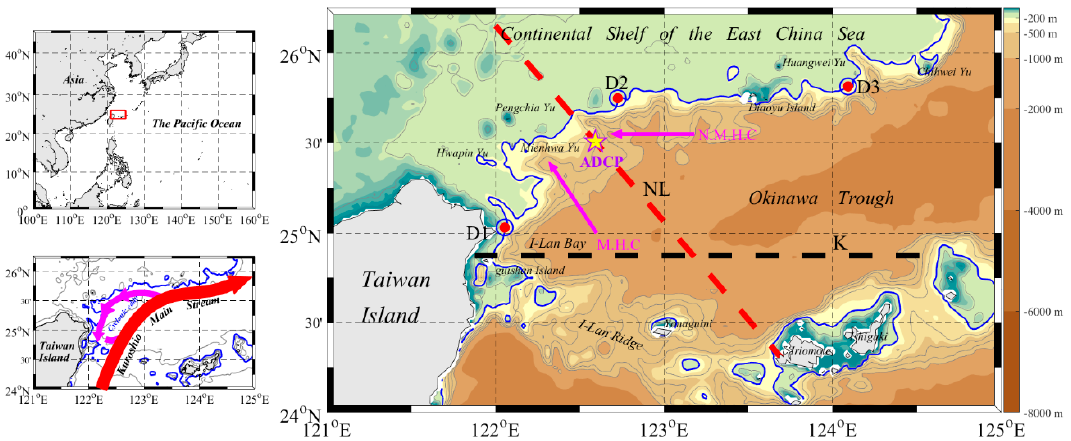
Figure 1. Location of the study area, the bathymetry off northeastern Taiwan, location of the mooring (25.51°N, 122.59°E; acoustic Doppler current profiler (ADCP) marked by yellow star), sections used in data analysis and a sketch of the horizontal flow pattern below the water depth of 200 m. The gray solid lines are isobaths of ETOPO1 [35], the blue solid line denotes the 200-m isobath and the red dots (D1 (25.03°N, 122.03°E), D2 (25.75°N, 122.72°E) and D3 (25.83°N, 124.10°E)) indicate segment points along the 200-m isobath. The red dashed line (NL) and the black dashed line (K) denote sections used in the data analysis. The panel in the lower-left corner shows the horizontal flow patterns off northeastern Taiwan in the subsurface layer below the water depth of 200 m. The deep red arrow denotes the main Kuroshio Current and the magenta arrows denote the counter-flow and the cyclonic eddy in the subsurface layer. The panel in the upper-left corner shows the location of the study area (red box).